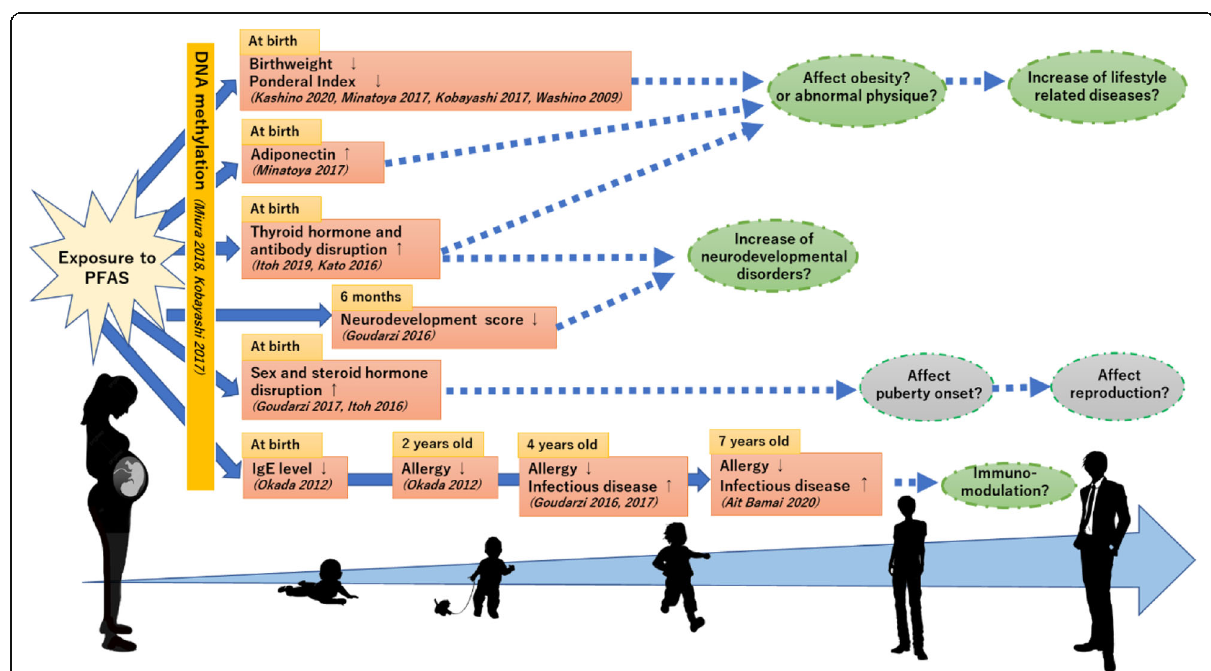
Fig. 2. Importance of longer follow-ups to examine prenatal exposure and health impacts at later life. Solid arrows and squares indicate the health impacts of fetal and intrauterine exposure, respectively, to PFAS on the health of children based on the results observed across 16 reports published by the Hokkaido Study. For immuno-function, we observe continuous PFAS effects up to 7 years old. Lower IgE levels at birth; lower risk of allergies at 2, 4, and 7 years old; and higher risks of infectious disease at 4 and 7 years of age have also been observed. Ovals indicate the possible health impacts at later life stages based on the reported